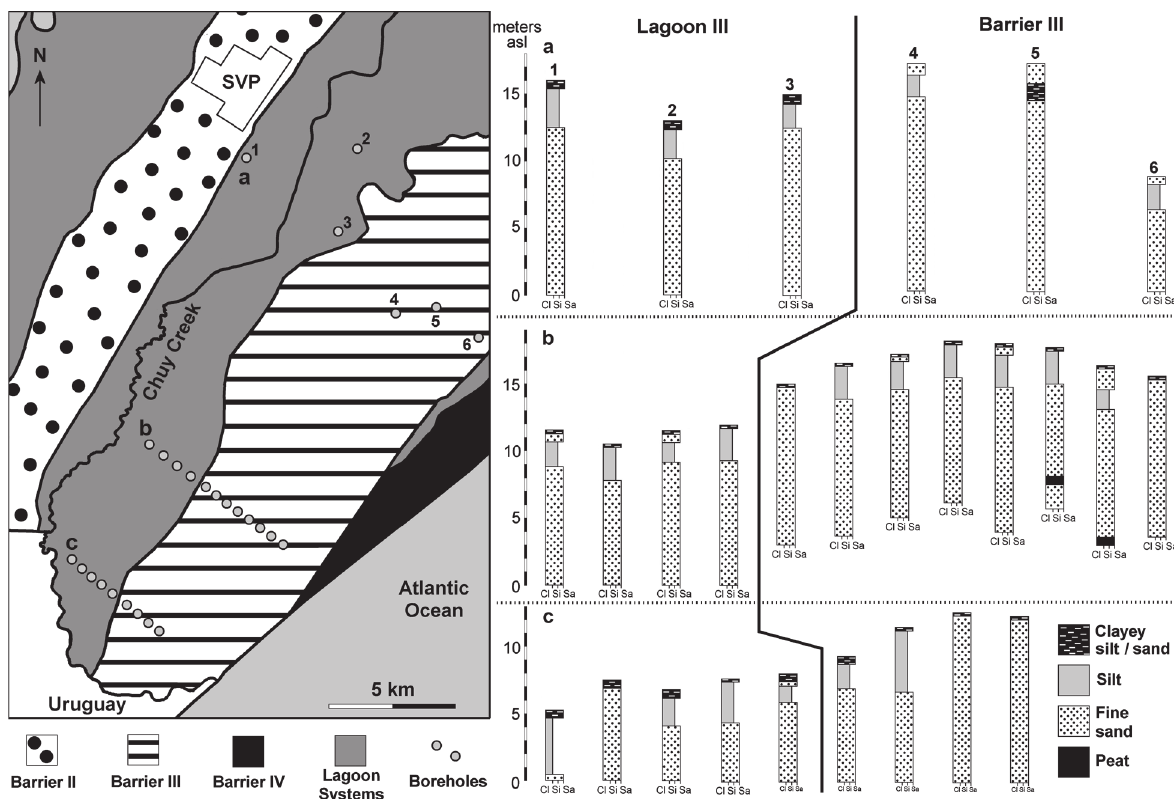
Figure 4 - Geological map of the southernmost CPRS near the town of Santa Vitória do Palmar (SVP) showing the NW-SE transect s ( a, b and c ) along which the boreholes shown on the right were